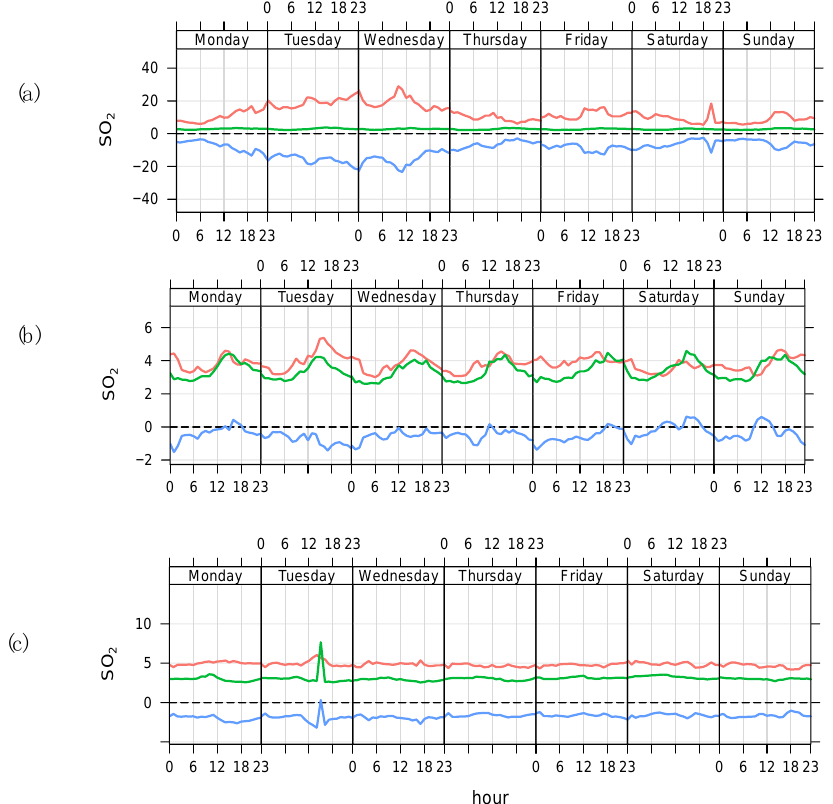
Figure A6. Temporal variations in SO 2 ( μ g/m 3 ) for Besiktas Station with three Phases: ( a ) Phase I d i fferen ces, B efo re: 30. 6 .20 1 5- 1 1 . 3 . 2 0 1 6 (Red), A f ter : 12. 3 . 201 6 -3 0 . 6 .20 1 7 (G r een ), A fter -Befo r e (Blu e ) ; 456